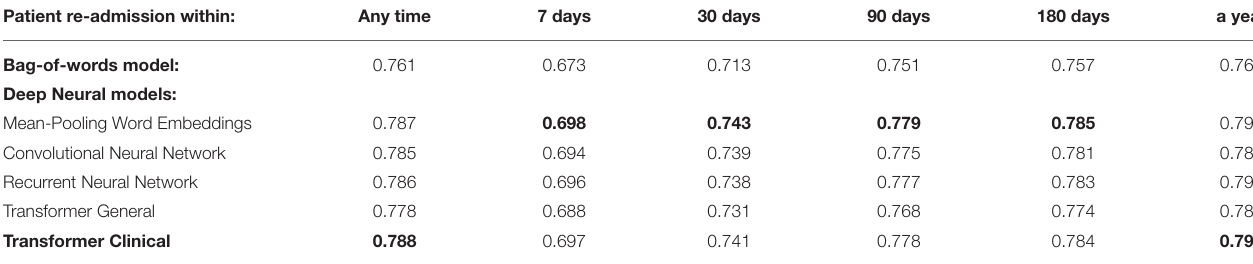
TABLE 3 | The overall performance of the models on the entire discharge summaries for the re-admission prediction targets.